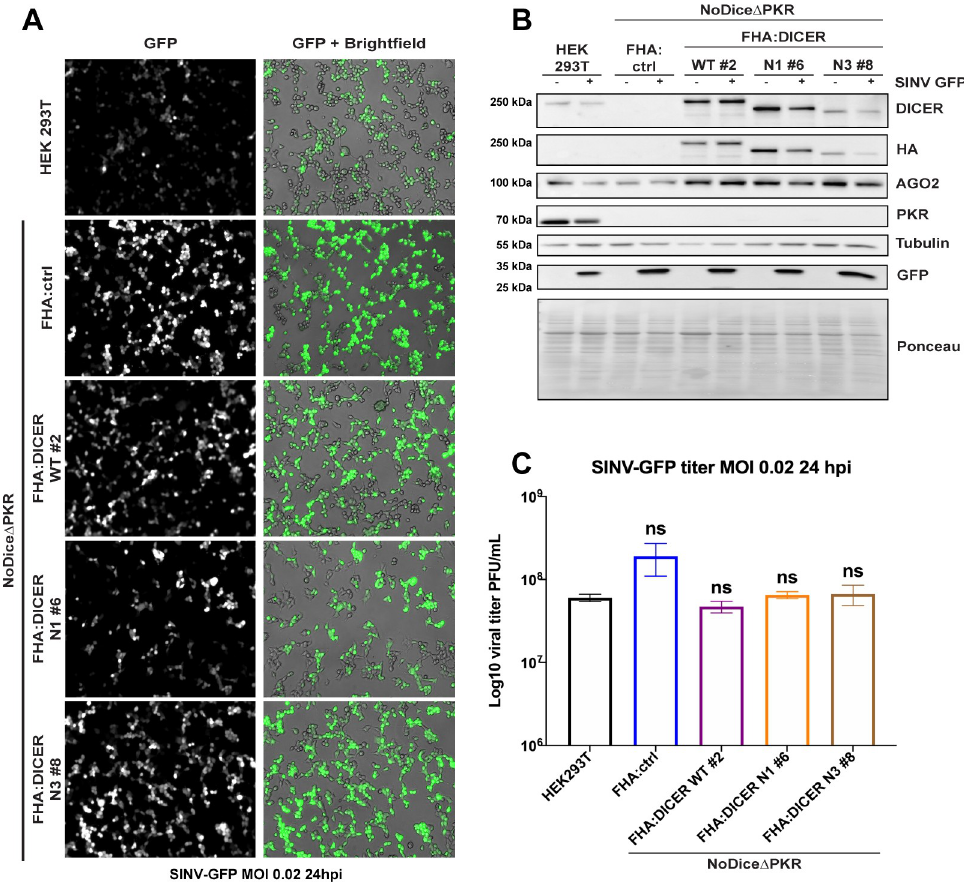
Fig 8. The antiviral effect of helicase-deleted DICER mutants requires PKR. A. GFP fluorescent microscopy pictures of HEK293T, NoDice Δ PKR:ctrl and FHA:DICER mutant cell lines infected with SINV-GFP at an MOI of 0.02 for 24 h. The left panel corresponds to GFP signal from infected cells and the right panel to a merge picture of GFP signal and brightfield. Pictures were taken with 5x magnification. hpi: hours post-infection. B. Western blot analysis of DICER (DICER and HA), AGO2, PKR and GFP expression in SINV-GFP-infected HEK293T, NoDice Δ PKR FHA:ctrl and FHA: DICER mutant cell lines shown in A. Gamma-Tubulin was used as loading control. C. Mean (+/-SEM) of SINV-GFP viral titers in the same cell lines as in A. infected at an MOI of 0.02 for 24 h (n = 3) from plaque assay quantification. ns: non-significant, ordinary one-way ANOVA test with Bonferroni correction.